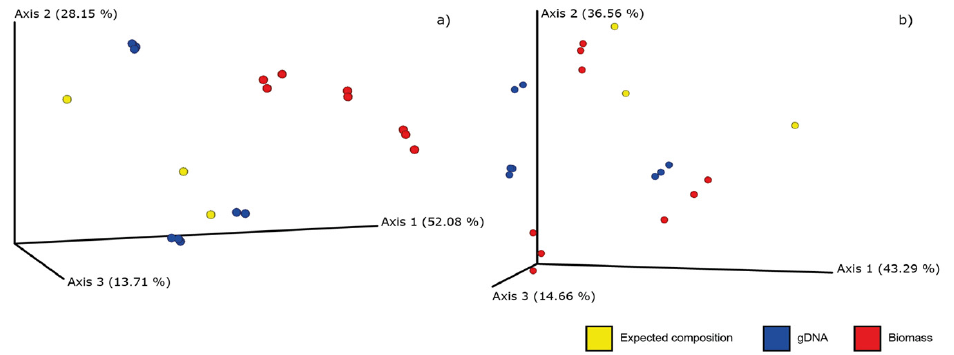
Figure 5. In the PCoA graphs, the yellow dots represent the expected composition samples, the red ones indicate the mock mixtures created starting from the raw plants and the blue ones indicate the mock mixtures obtained from genomic DNA. ( a ) PCoA representation considering ITS2 analysis, while ( b ) psbA-trnH